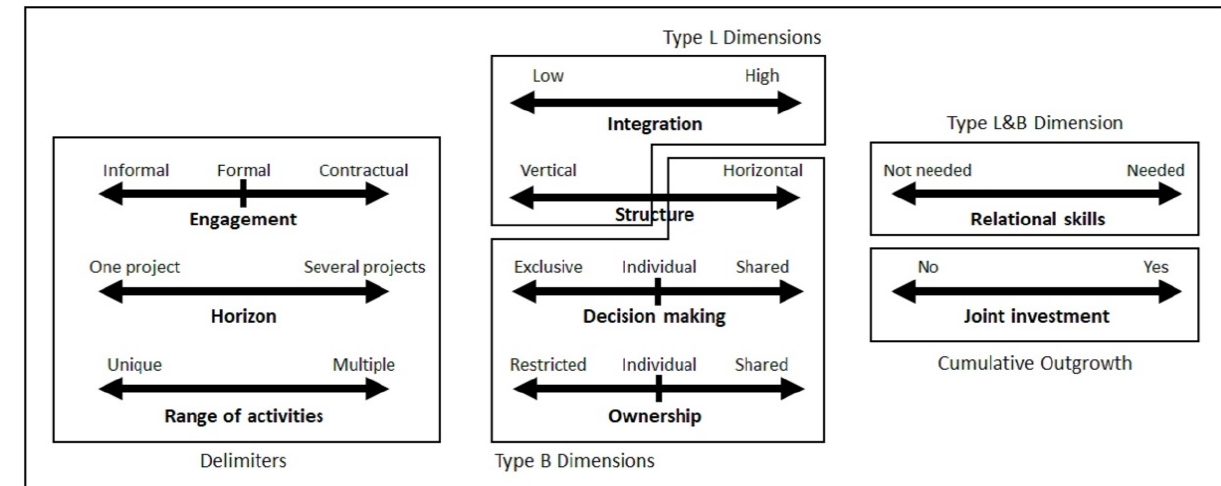
Figure 5. The multidimensional profile.